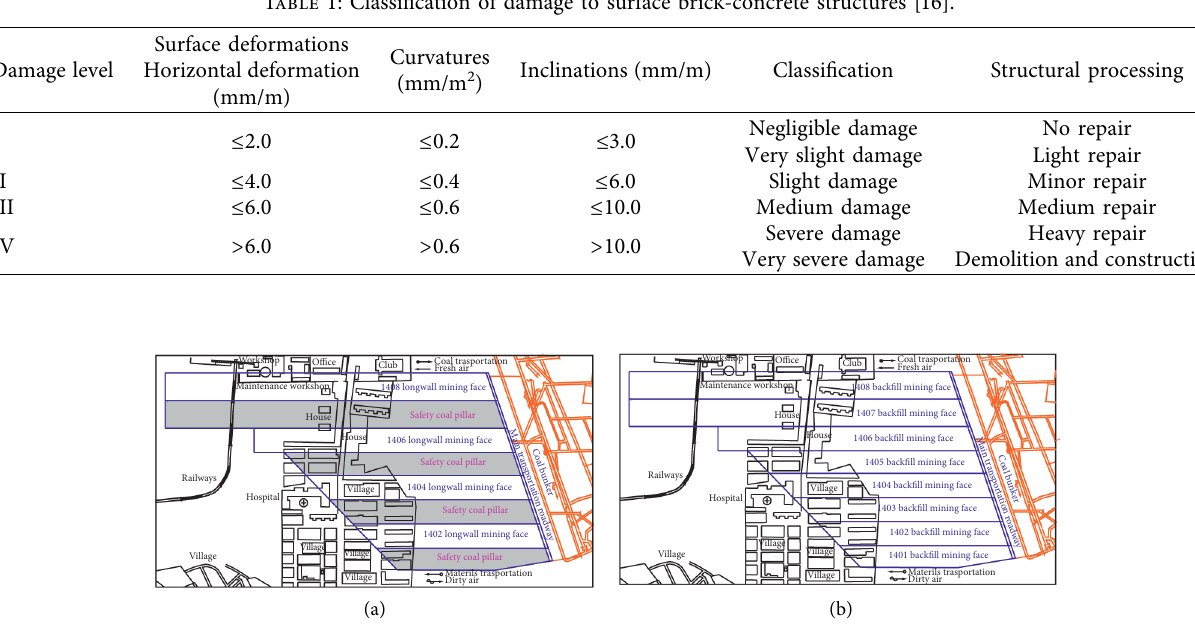
Figure 3: Roadway layouts of mining face for two mining methods: (a) strip mining; (b)